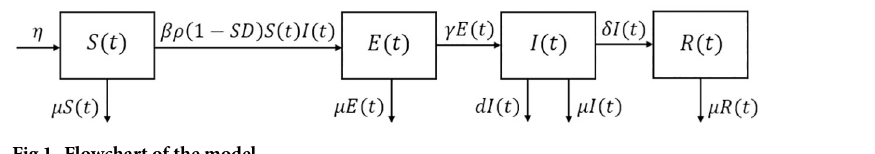
Fig 1. Flowchart of the